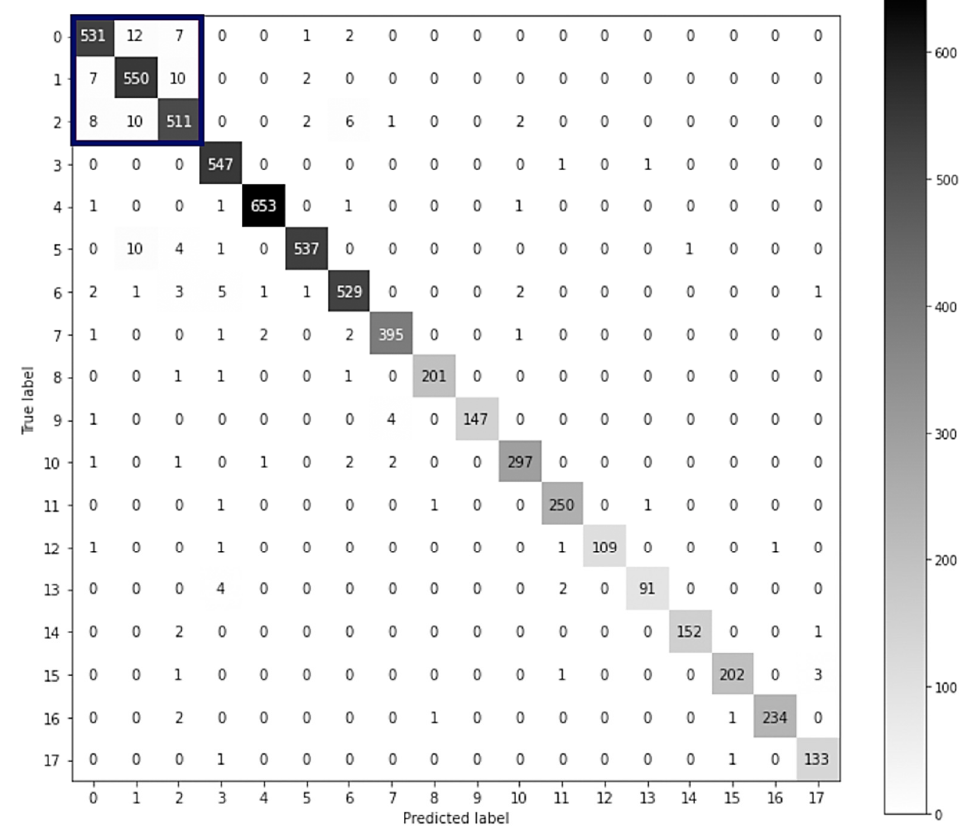
Figure 5. The confusion matrix of the KU-HAR dataset classification using the selected model.